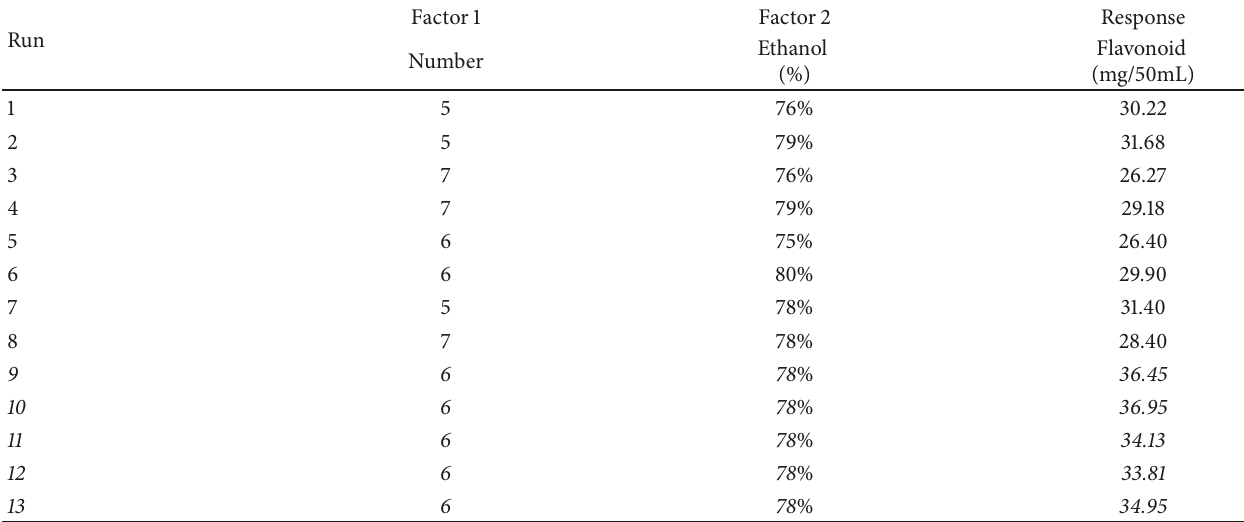
Table 3: Central composite design and